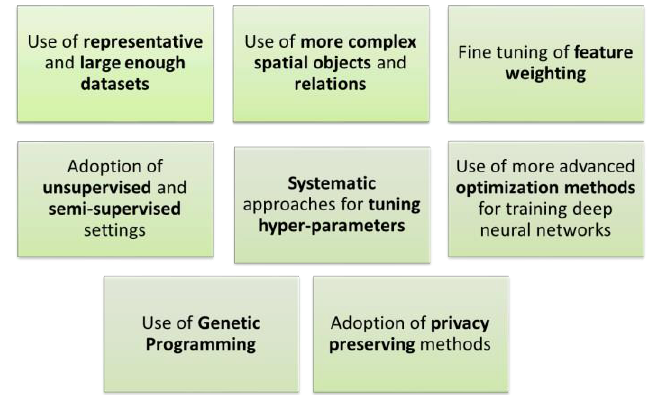
Figure 10. Main research gaps identified in the present